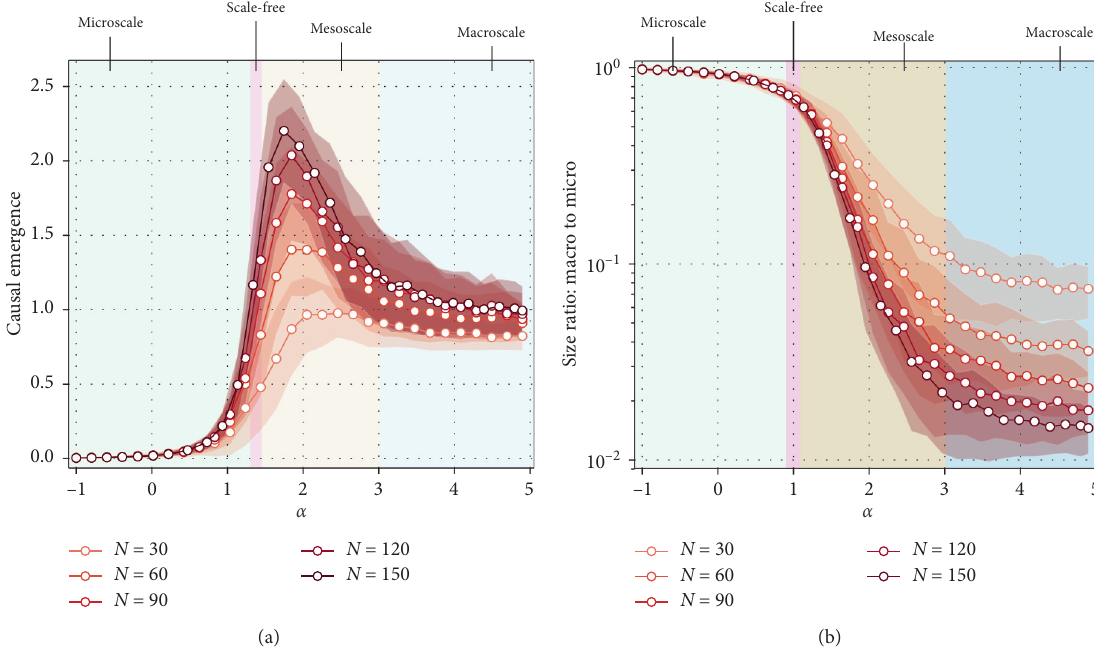
Figure 5: The emergence of scale in preferential attachment networks. (a) By repeatedly simulating networks with different degrees of preferential attachment ( α values) with m � 1 new edge per each new node, and running them through a greedy algorithm (described in Materials & Methods), we observe a distinctive peak of causal emergence once the degree of preferential attachment is above α � 1, yielding networks that are no longer “scale-free.” (b) The log of the ratio of original network size, N , to the size of the macroscale network, N M . Networks with higher α values—more star-like networks—show drastic dimension reductions, and in fact, all eventually reach the same N M of 2. Comparatively, random trees ( α � 0 . 0 ) show essentially no informative dimension